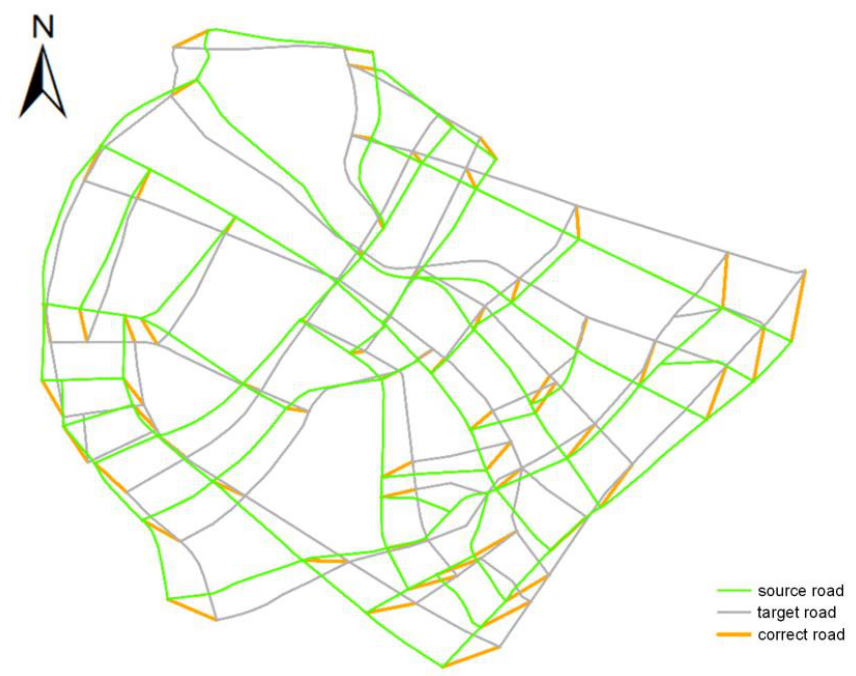
Figure A1 . Matching results of DTRM for Area 1 (R1).